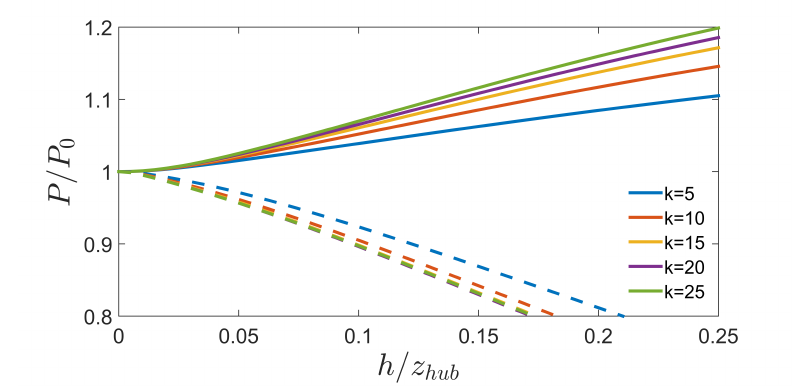
Figure 6. Power output predictions for several windbreak porosities based on the top-down model along with LES data. Solid lines indicate S x = ∞ , and dashed lines indicate S x =